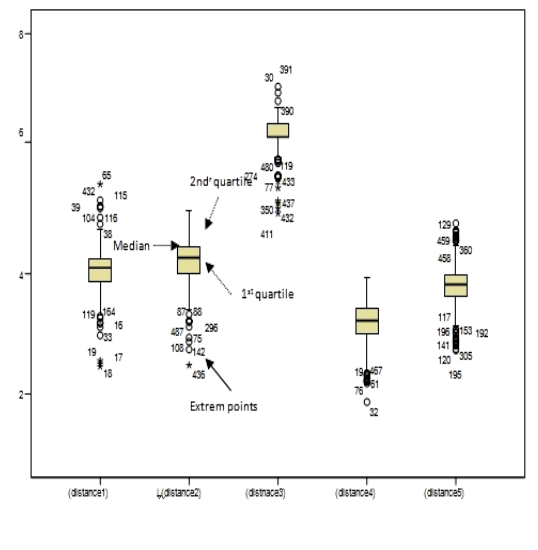
Figure I. Distribution of the firms of the sample according to the disclosure